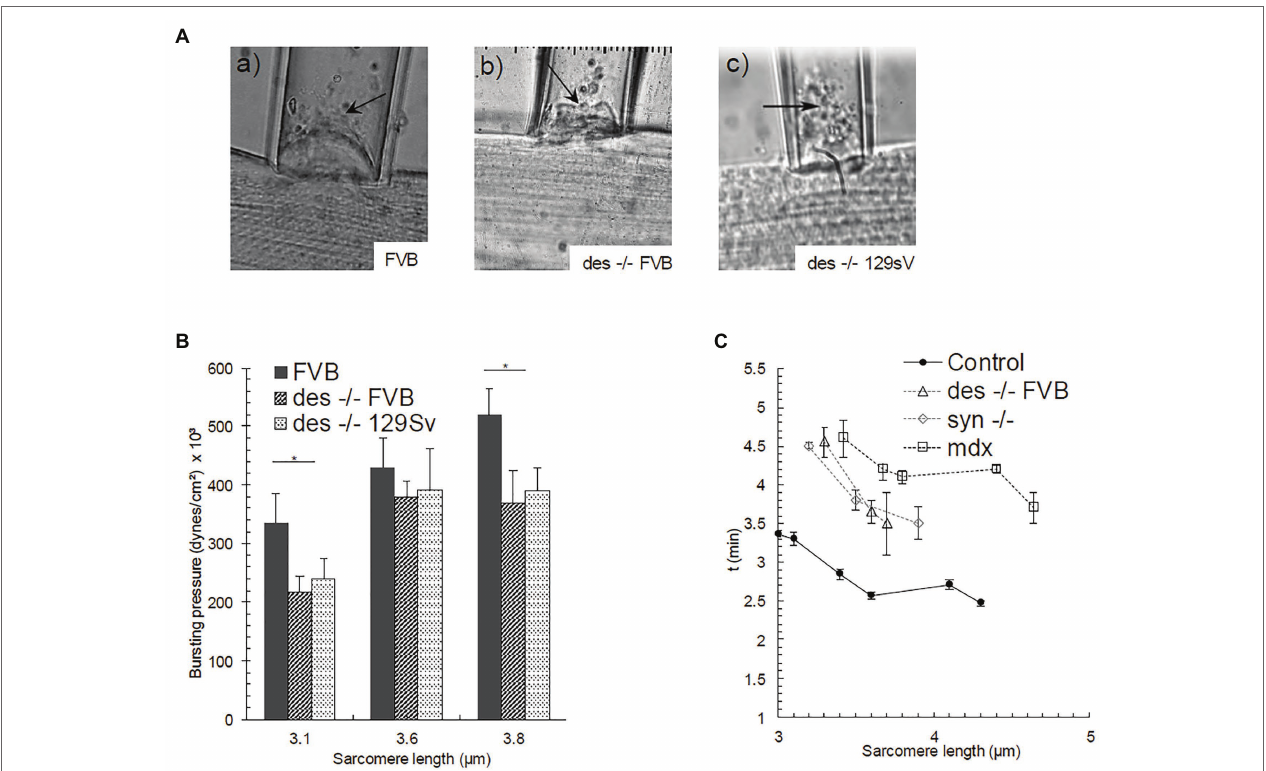
FIGURE 3 | Bursting of the sarcolemmal bleb in (Aa) FVB, and (Ab) , (Ac) des − / − strains (SL = 3.5, 3.8, and 3.6 μ m respectively). Bursting is denoted with an arrow. (B) P bursting as a function of SL. Bars indicate mean ± SD. *Significant difference between des − / − FVB and its control strain at the same SL. Statistical analysis was performed with a one-way ANOVA. (C) Time needed for the bleb to reach a steady-state as a function of SL in Control FVB, des − / − (FVB), syn − / − , and mdx myofibers. Bars indicate mean ± SE.